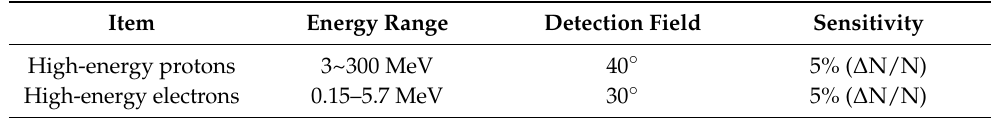
Table 1. Main technical indexes of the HEPD on the FY-3E